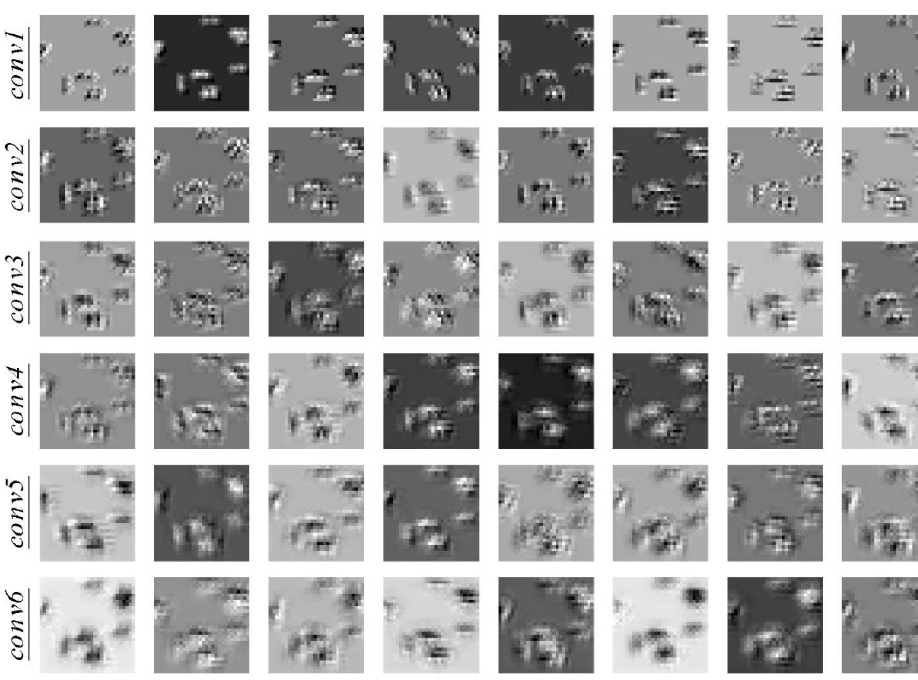
Figure 12. Visualization of convolutional layers.